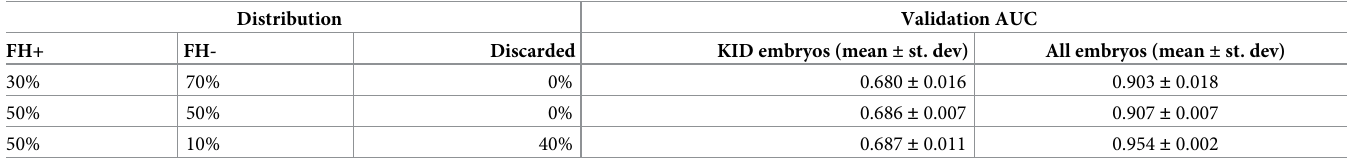
Table 2. Five-fold cross-validation experiment on varying the distribution between FH+, FH- and discarded embryos used during training. The area under the curve (AUC) was evaluated for both transferred embryos with known implantation data (KID) and all embryos for each validation data set.